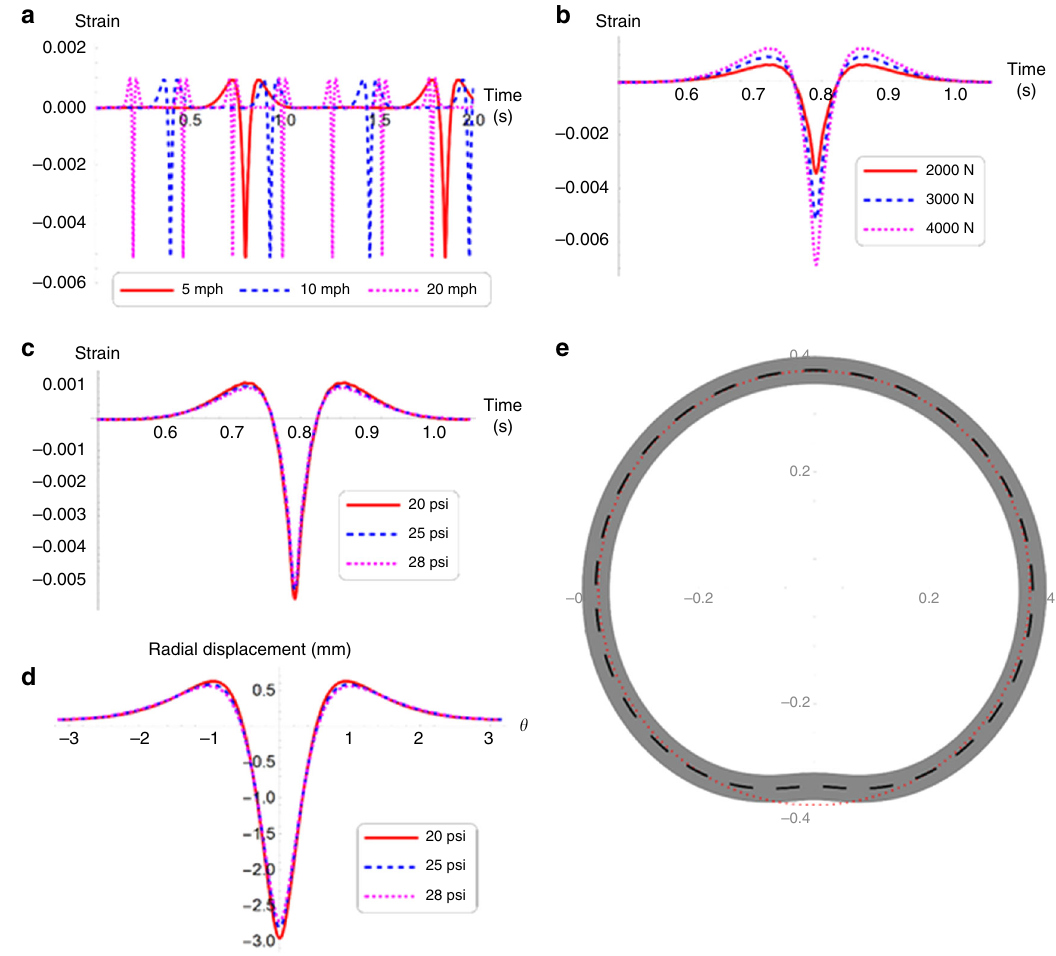
Fig. 4 Tire modeling results. a The strain as a function of time for three speeds is estimated using Eq. (5) for a load of 3000 N and pressure of 28 psi. It can be observed that the amplitude of the strain remains the same with speed. b The simulated strain in the tire as a function of time for three loads is shown for a speed of 5 mph, and pressure of 28 psi. c The simulation results for strain as a function of time for three pressures at a speed of 5 mph and a load of 3000 N. d The simulated radial displacement as a function of angular position for three tire pressures for a load of 3000 N and speed of 5 mph. It can be observed that the displacement and hence the strain increases with decrease in the tire pressure for a given load. e A representative plot of the simulation results for tire deformation (m) at any given speed. The displacement shown corresponds to that at 5 mph, 3000 N force and 28 psi pressure with a fi ve times ampli fi